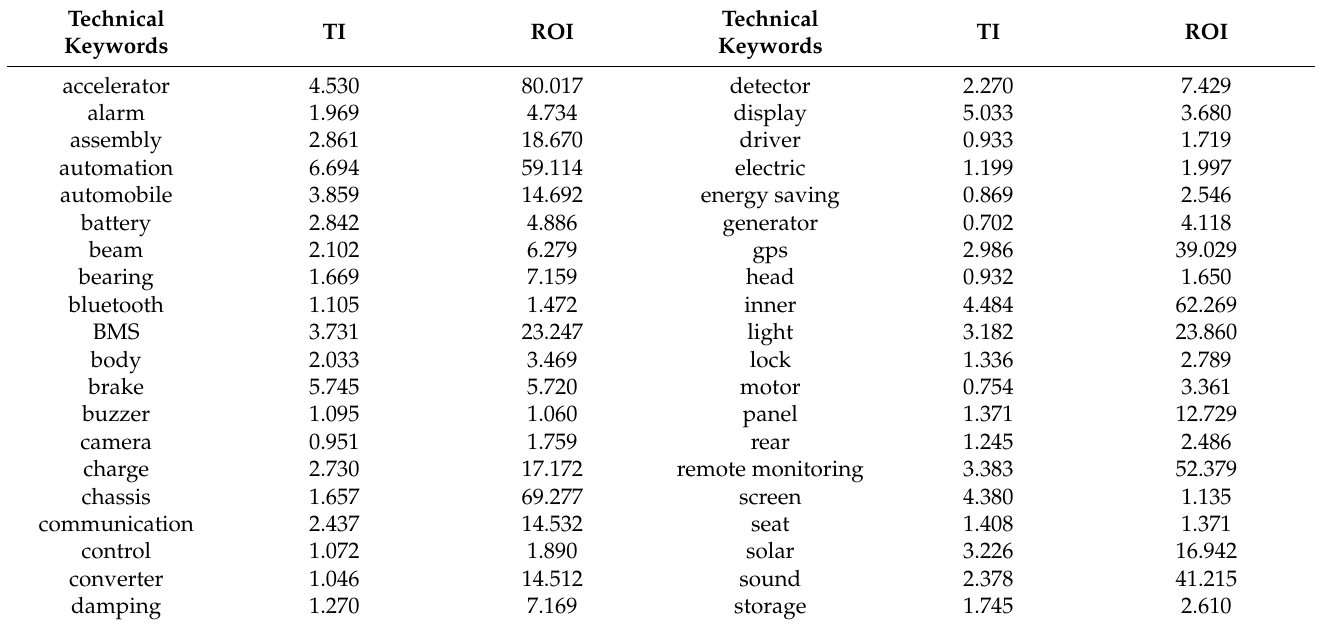
Table 6. The importance and increase rate of technical keywords in the EVs field.